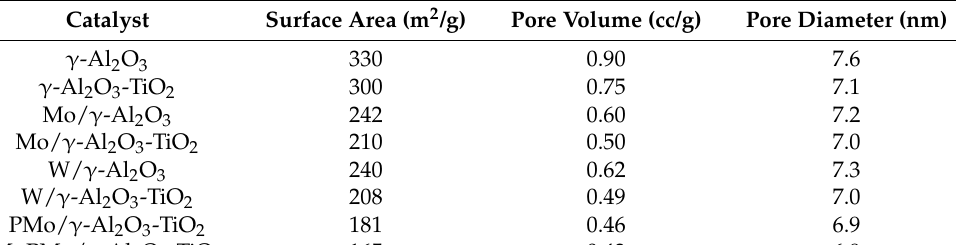
Table 1. Textural properties of the catalysts used for oxidative desulfurization and denitrogenation. (error ± 3.0%).